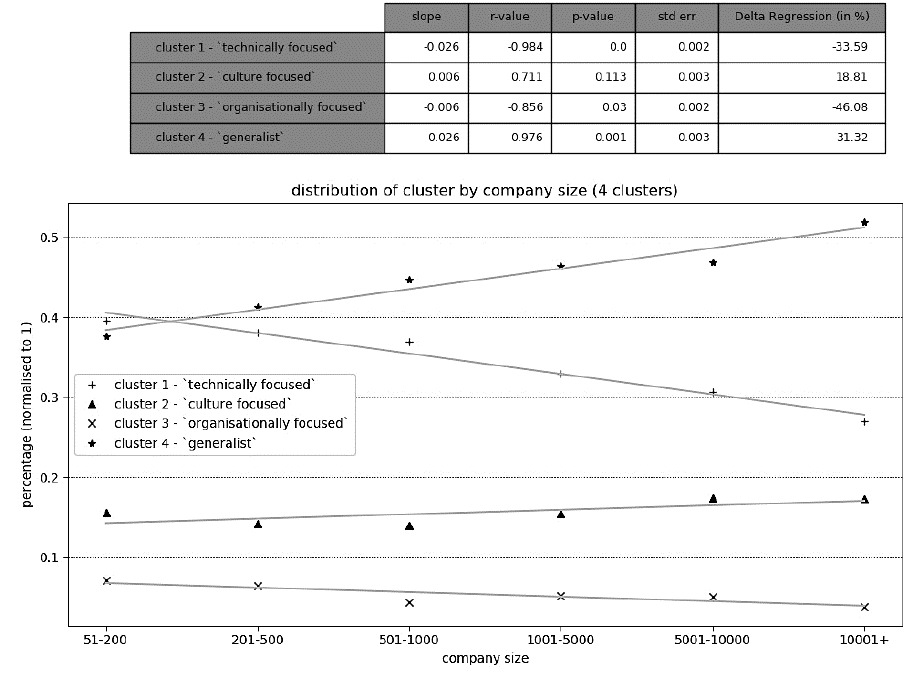
Figure 9. Slope of regression lines of clusters by company